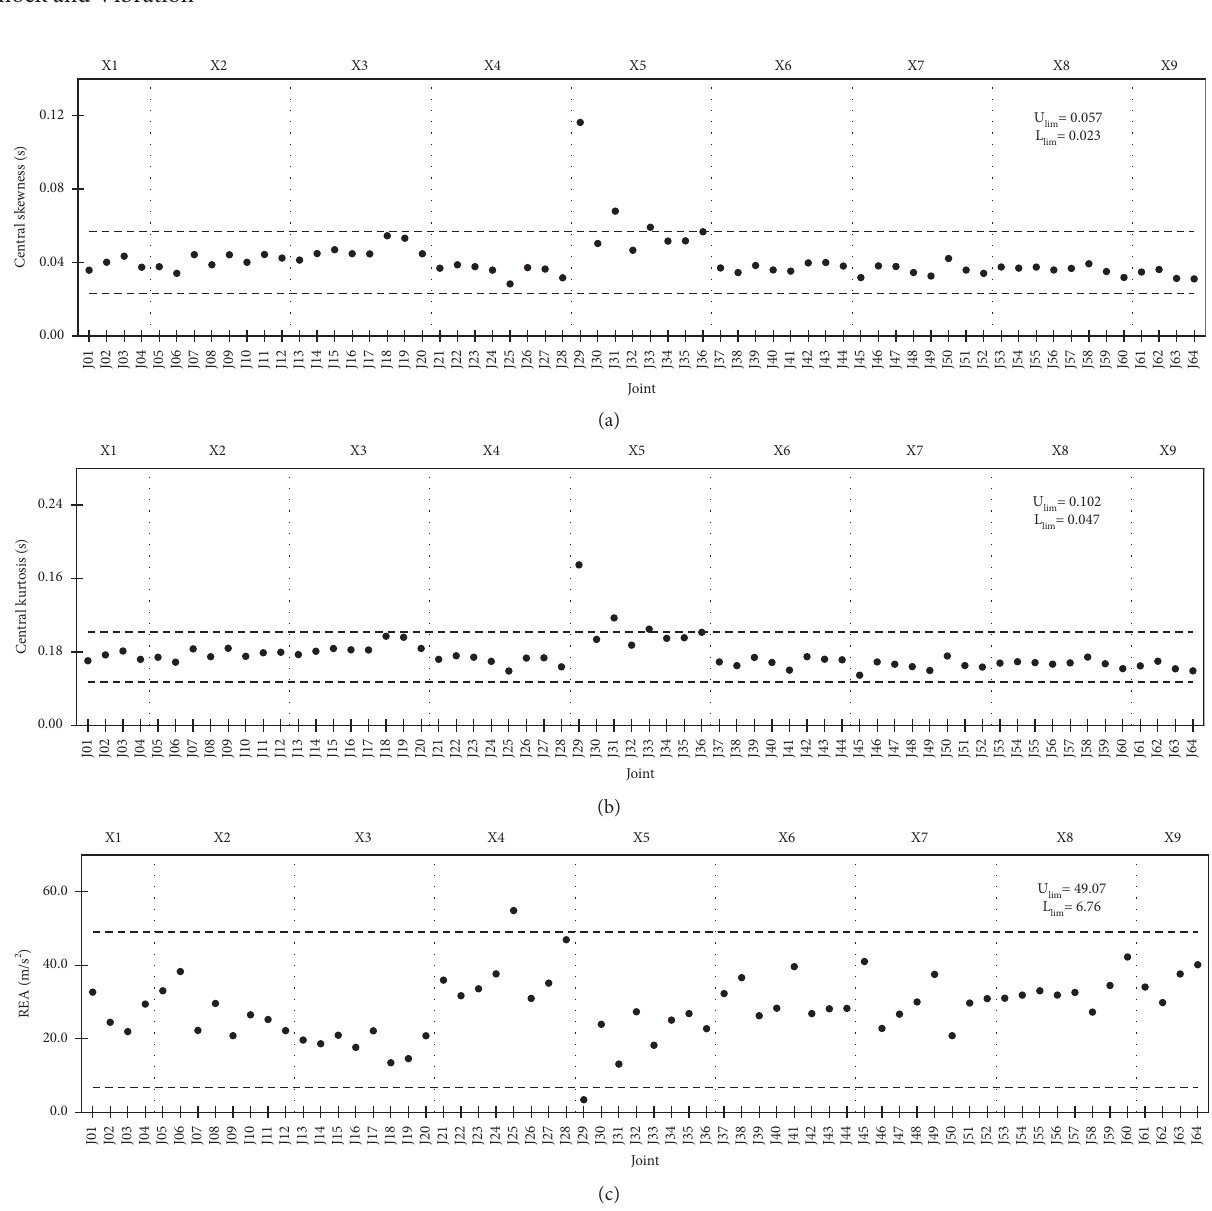
Figure 7: Analysis results of the normalized central moments and the root energy amplitude from the average of 5